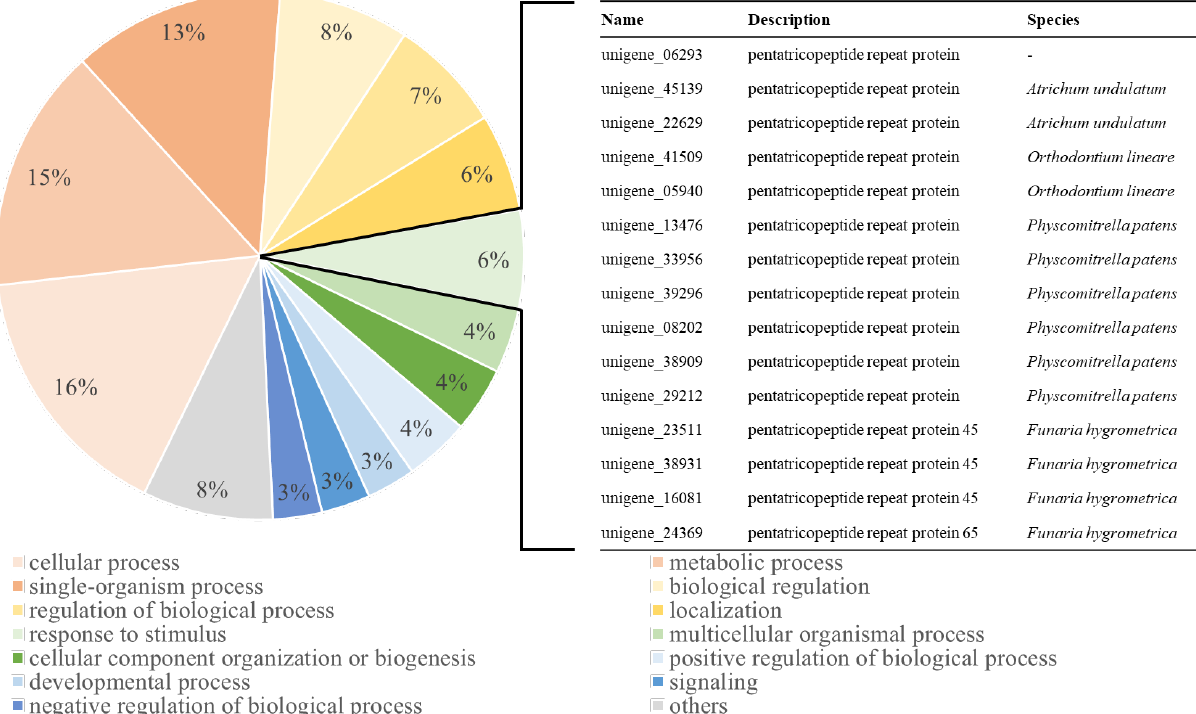
Figure 6. Gene ontology (GO) analysis in the “biological processes” category for unigenes upregulated in response to CA-12 treatment. Thirteen GO terms were over-represented, with the rest collectively indicated as “others”. In the circle graph, the percentage occupied by each GO term is expressed as “%”. Fifteen unigenes encoding pentatricopeptide repeat (PPR) protein were identified in “response to stimulus” (6%), which is a distinguished feature for A. turgidum . Details of GO information for groups upregulated in CA-12 treatment are presented in Table S6. Table 3. KEGG analysis of DEGs upregulated in CA-12.